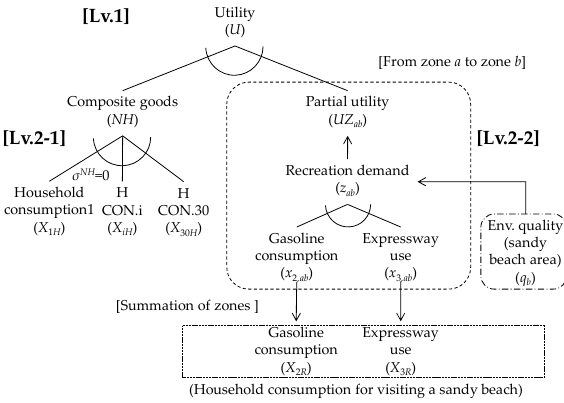
Figure 1. Structure of household .